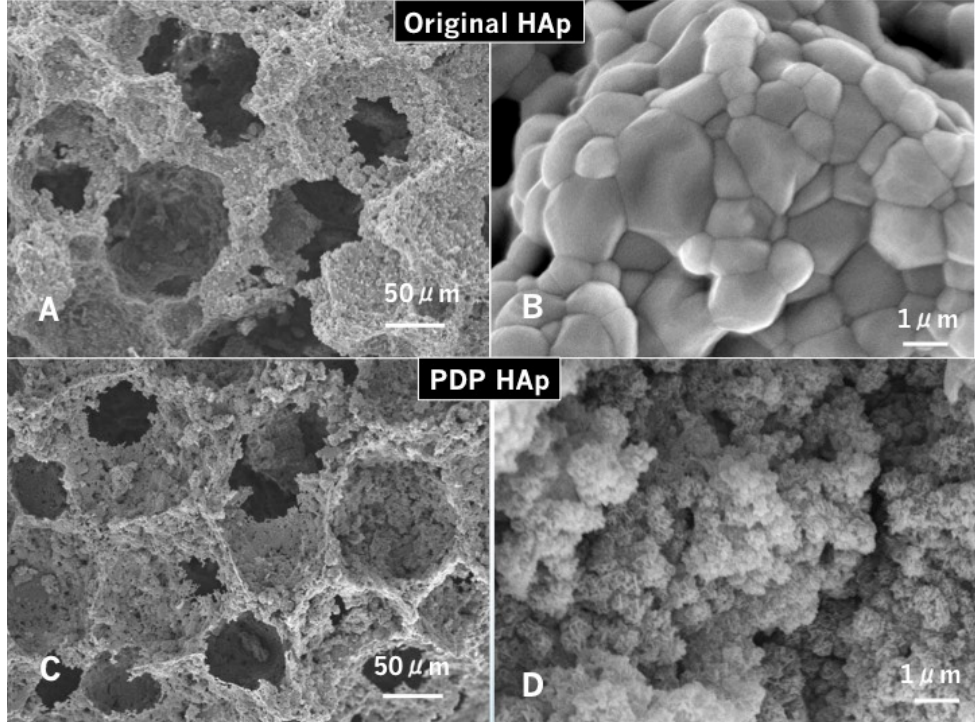
Figure 3. Scanning electron microscopy (SEM) photographs of original HAp ( A , B ) and PDP-HAp ( C , D ). ( A ) Interconnected pore structure. ( B ) Smooth surface. Note: uniform large grains (1.0–3.0 µ m). ( C ) Irregular surface. Note: small dot holes (micropores) on macropore walls. ( D ) Spherical moss-like grains (0.5–1.0 µ m) forming needle-like nano-sized